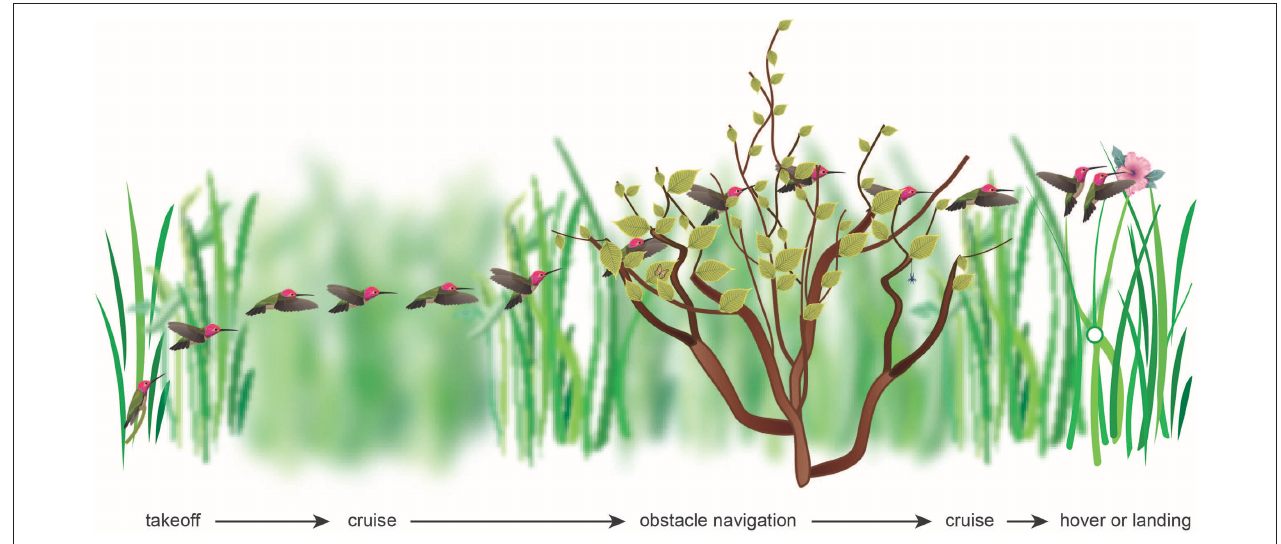
FIGURE 1 | The flight of a bird through its natural environment requires that it make visually complex transitions, most of which have yet to be studied. The visual algorithms may include maintaining balanced optic flow or avoiding high optic flow, or maintaining constant velocity, acceleration, deceleration, height, rate of image expansion, or rate of change of time to